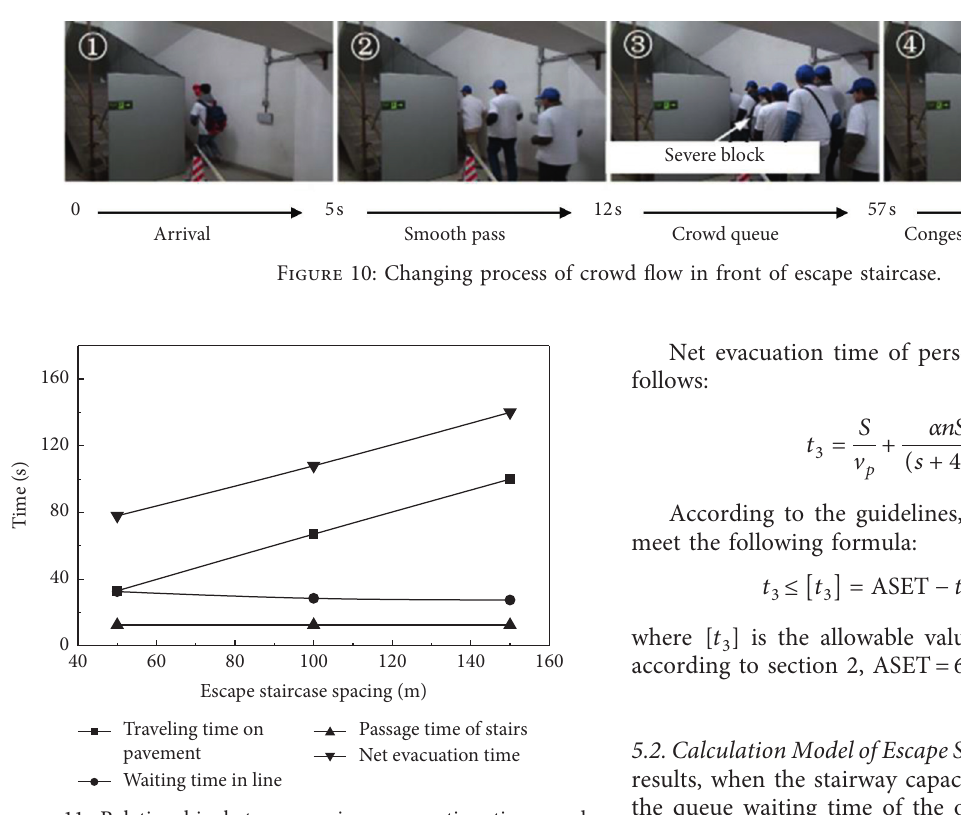
Figure 11: Relationship between various evacuation times and escape stair